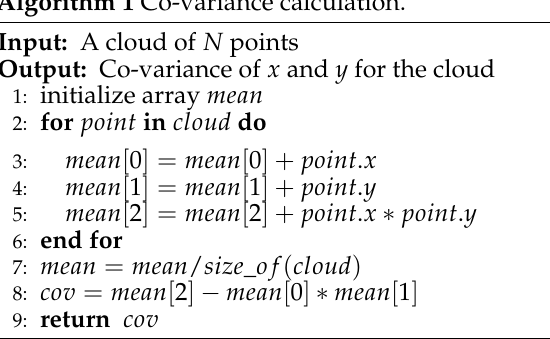
Algorithm 1 Co-variance